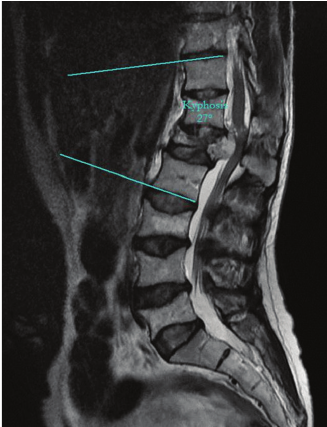
Figure 2: Preoperatively, the measured T12–L2 local kyphotic angle.